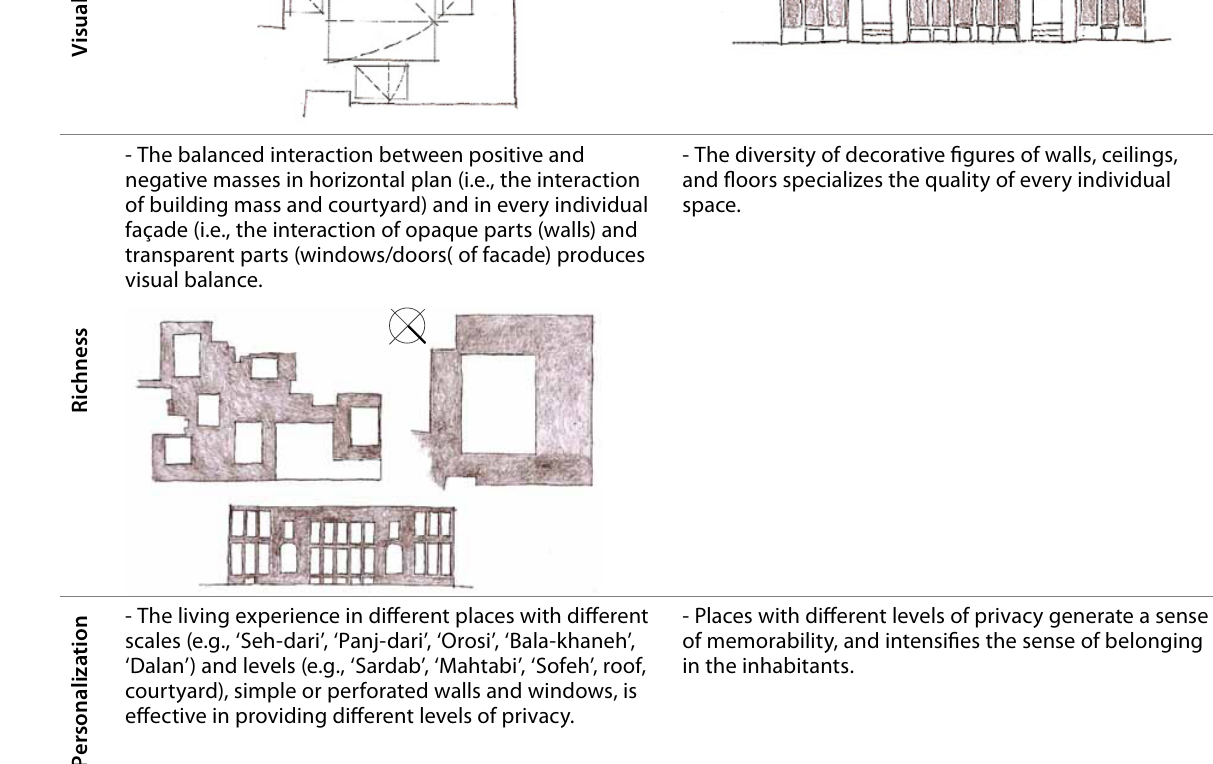
- The diversity of decorative figures of walls, ceilings, and floors specializes the quality of every individual space.